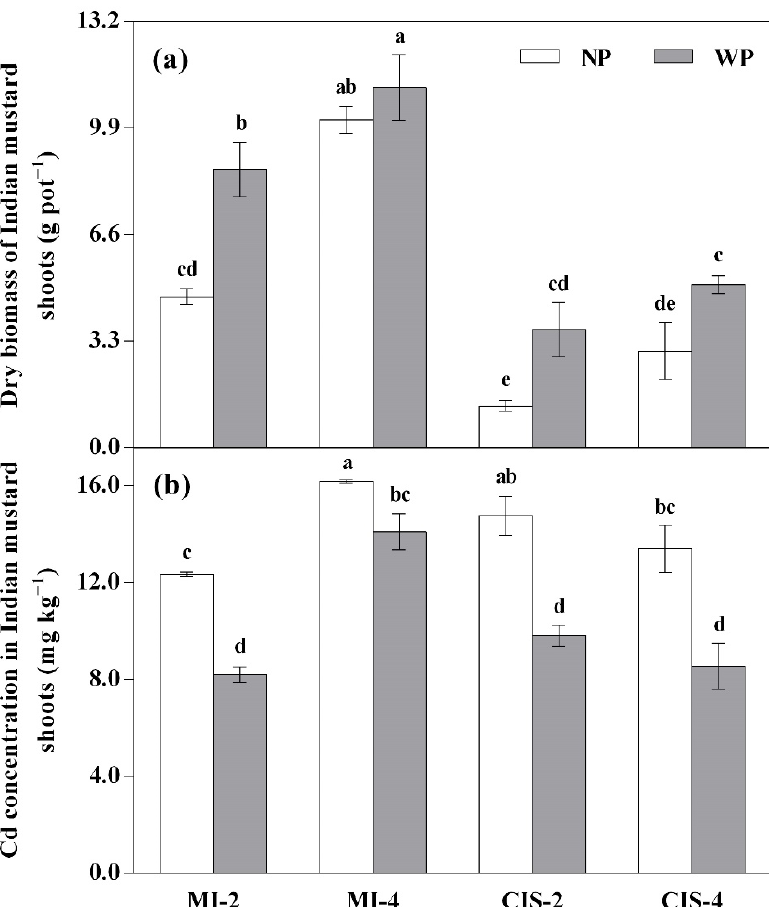
Figure 2. Effects of planting pattern and peat application on dry biomass ( a ) and Cd concentration ( b ) in Indian mustard shoots. For explanation of treatment notations, see Table 2; data are expressed as means ± SD ( n = 3); different lowercase letters (e.g., a, b, c, etc.) indicate significant ( p < 0.05) differences among the treatments based on the Tukey test. Table 5. Differences in dry biomass, Cd concentration, and Cd accumulation in maize shoots in different treatments. Treatment